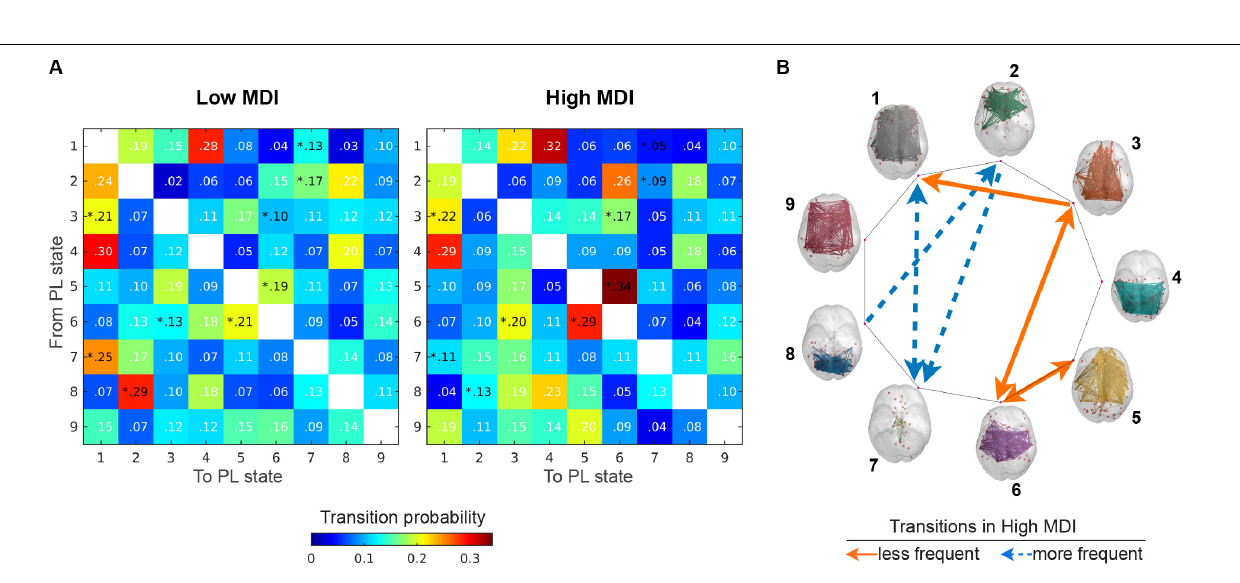
FIGURE 7 | Transition probabilities between PL states. (A) Displays the switching matrices showing the probability of transition from a given PL state (rows) to any other PL states (columns) in low (left) and high MDI (right). The color bar is used to scale the transition probabilities between PL states. (B) Illustrates the transitions between PL states (rendered on the cortical surface) that significantly ( p < 0.05) increased (solid orange line) and decreased (dashed blue line) for participants with high compared to low MDI. Analysis via a non-parametric permutation-based t -test. * p < 0.05. MDI, Major Depression Inventory; PL,